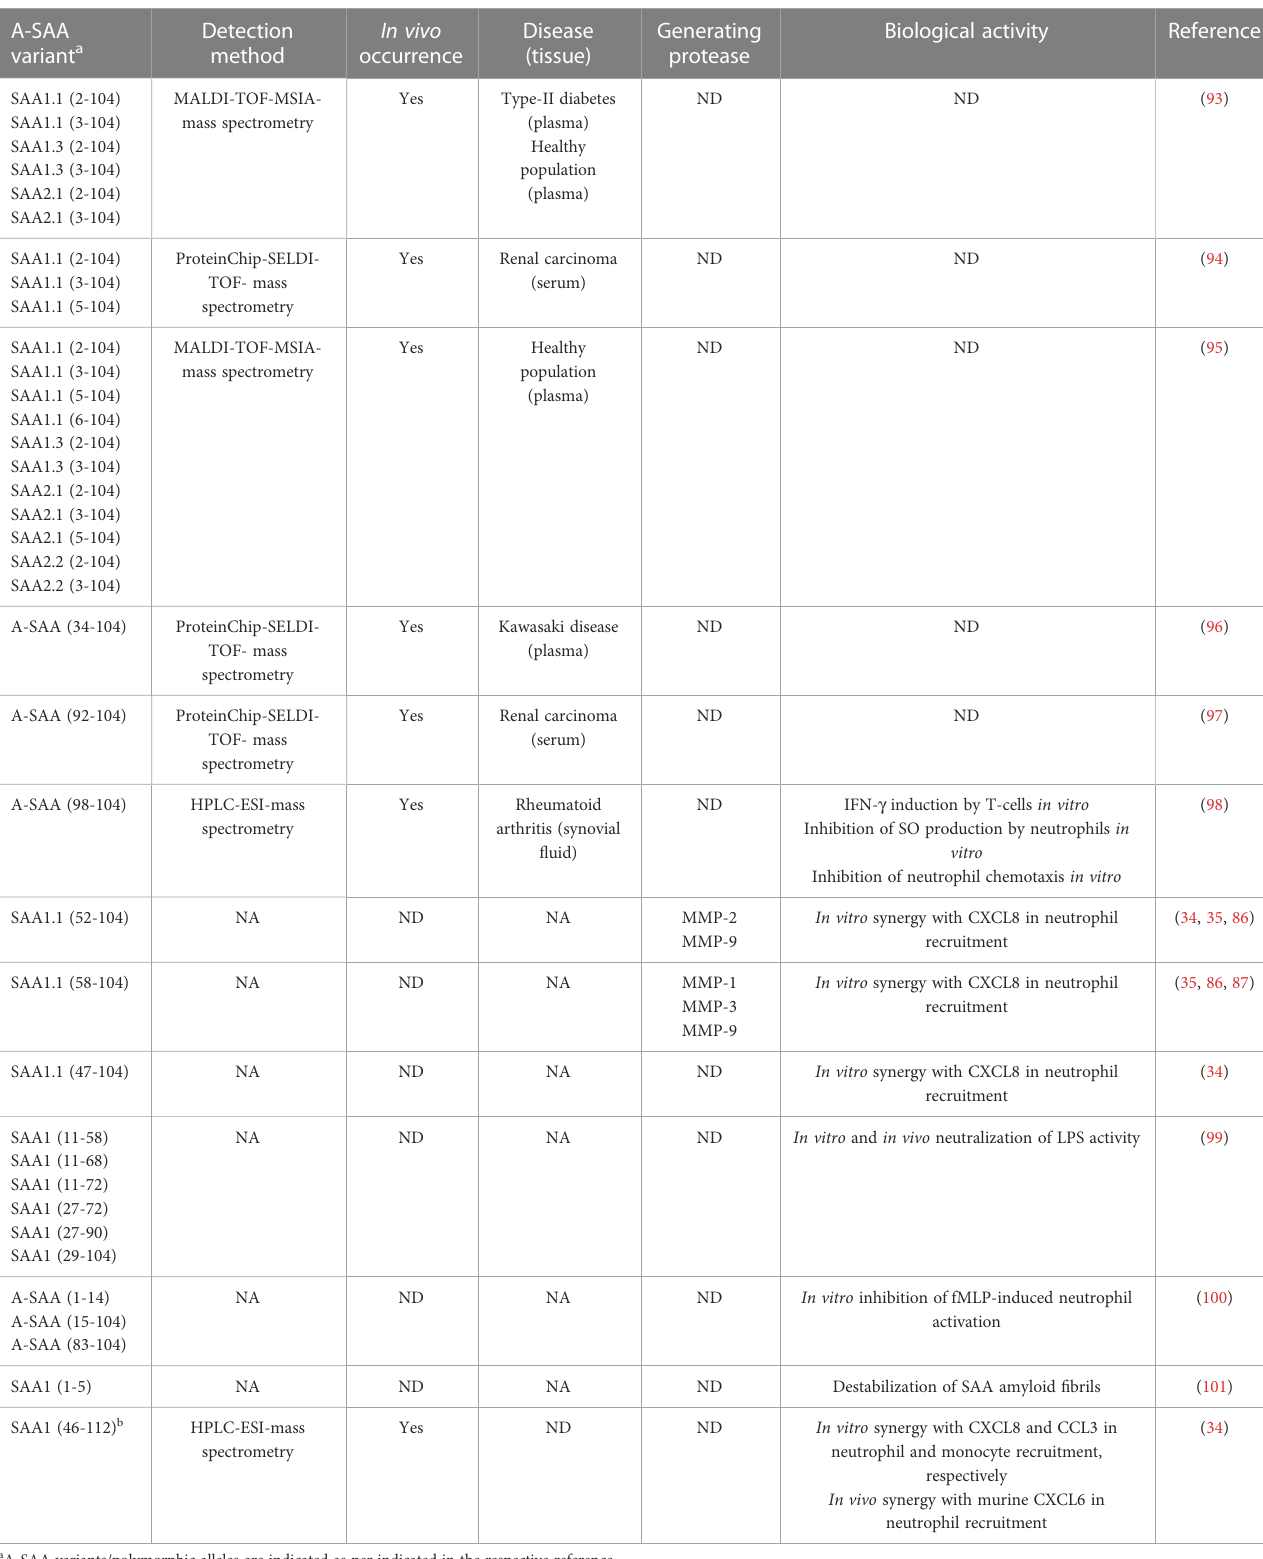
TABLE 3 Natural occurrence, processing enzymes and biological activity of reported A-SAA-derived